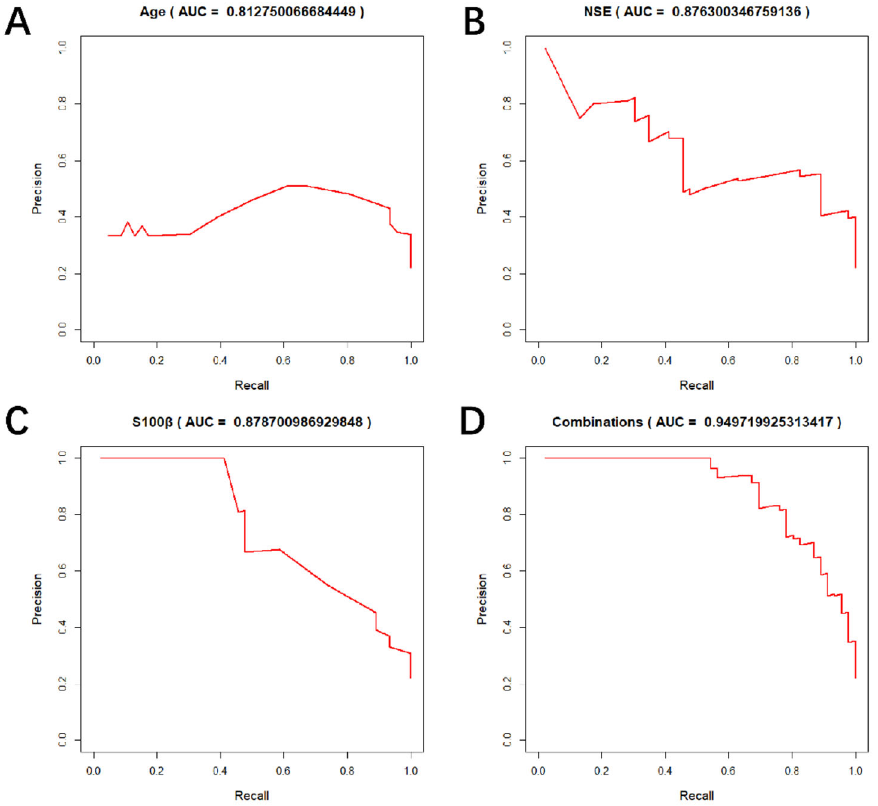
Figure 3. PR curves of age ( A ), postoperative serum NSE level ( B ), postoperative serum S100 β level ( C ), and the combination of all three features ( D ) for discriminating POD in older participants undergoing MVD surgery.